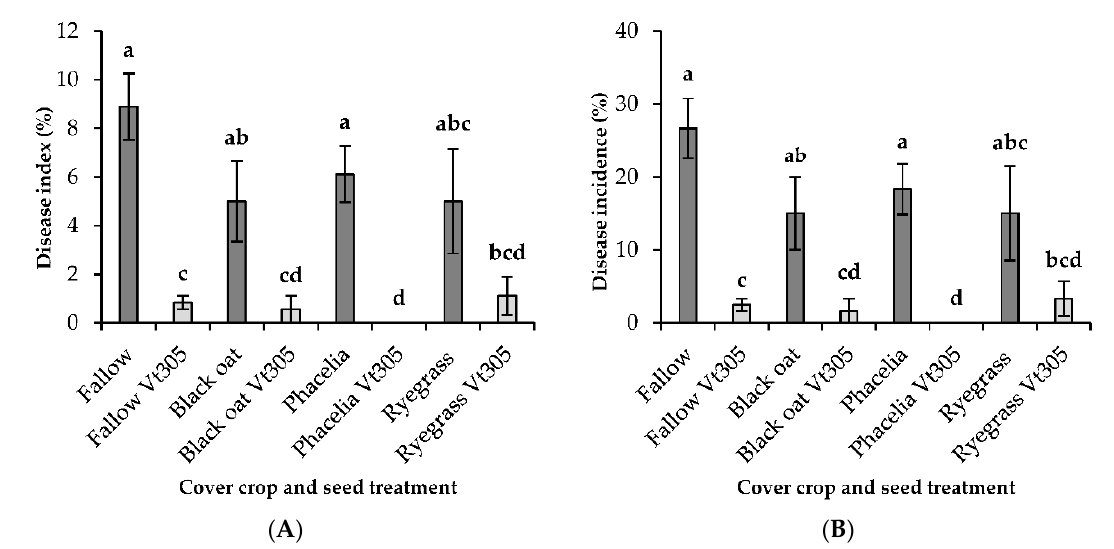
Figure 3. Effect of treatment with V. isaacii Vt305 on Verticillium wilt of cauliflower in a grower’s field in Puurs during the growing season of 2015 in four cover crop systems. Cauliflower seeds (cultivar Clarina) were treated with tap water or a microsclerotia (MS) suspension (500 MS per seed) indicated with ‘Vt305 ′ . ( A ) Disease index of the cauliflower plants at harvest. The disease index was calculated based on the scores for vascular discoloration via the formula of Townsend–Heuberger [(0*a + 1*b + 2*c + 3*d)/(e*f)]*100; letters a, b, c, and d, are the numbers of plants for each disease score, the letter e is the highest score (=3), and f represents the number of observations (= 20). ( B ) Disease incidence of Verticillium wilt. Values are the mean of 4 replicates and the vertical bars represent the standard error of the mean. Bars indicated with the same letter are not significantly different according to a Mann– Whitney test ( p < 0.05).